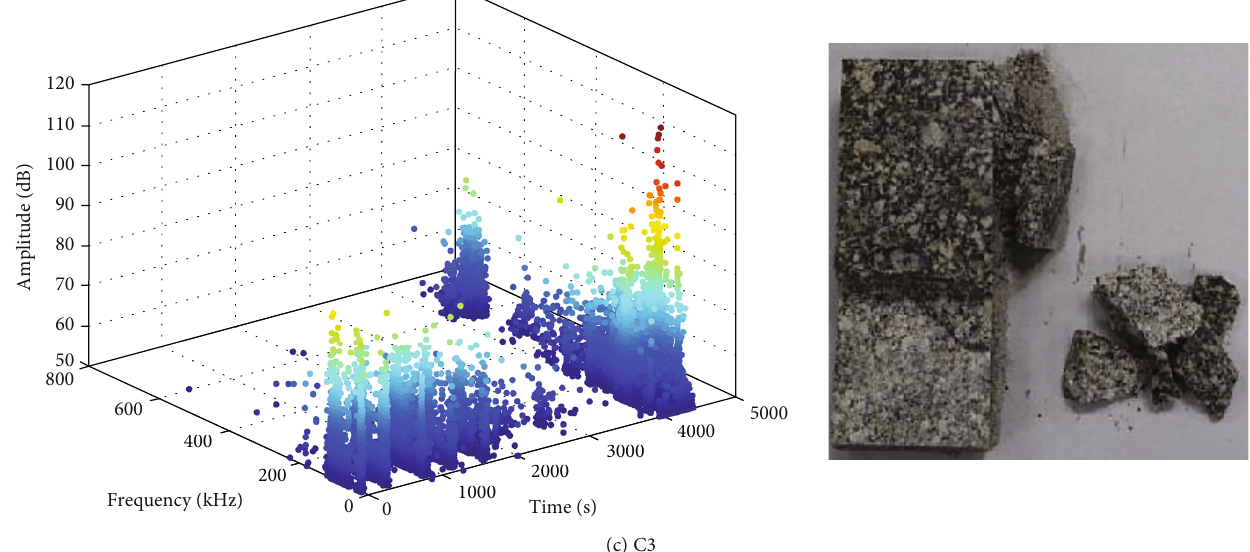
Figure 5: Acoustic emission spectrum characteristics and fragments of rock burst in